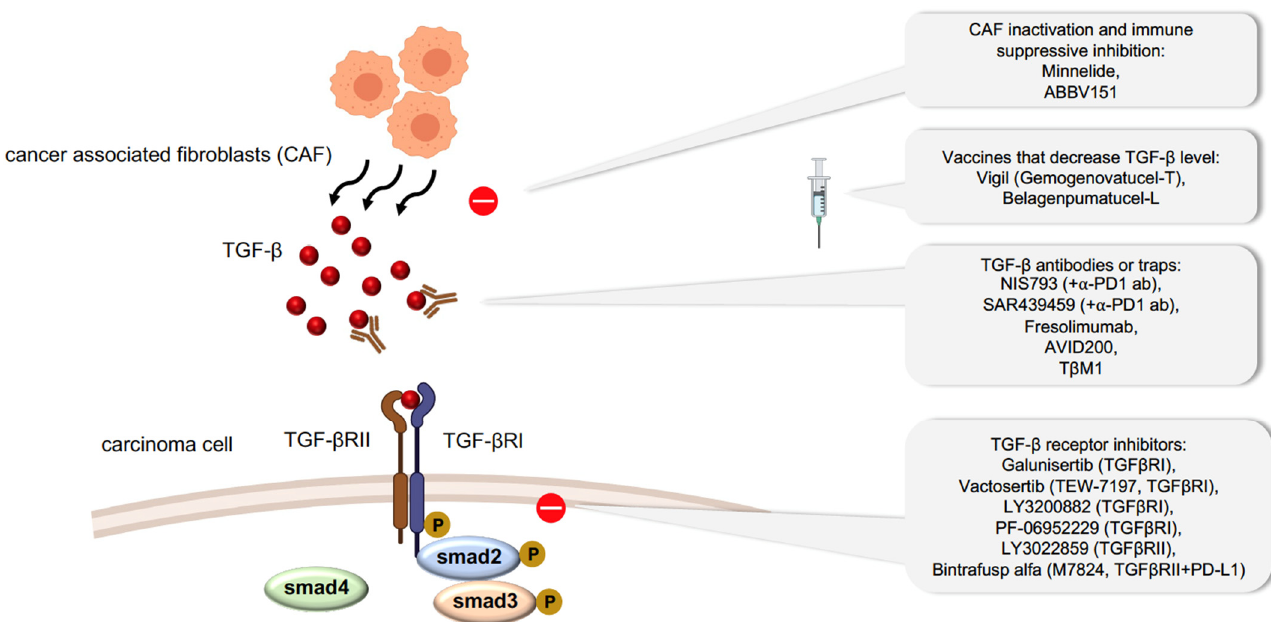
Figure 2. Therapeutic approaches targeting TGF- β signaling pathway.